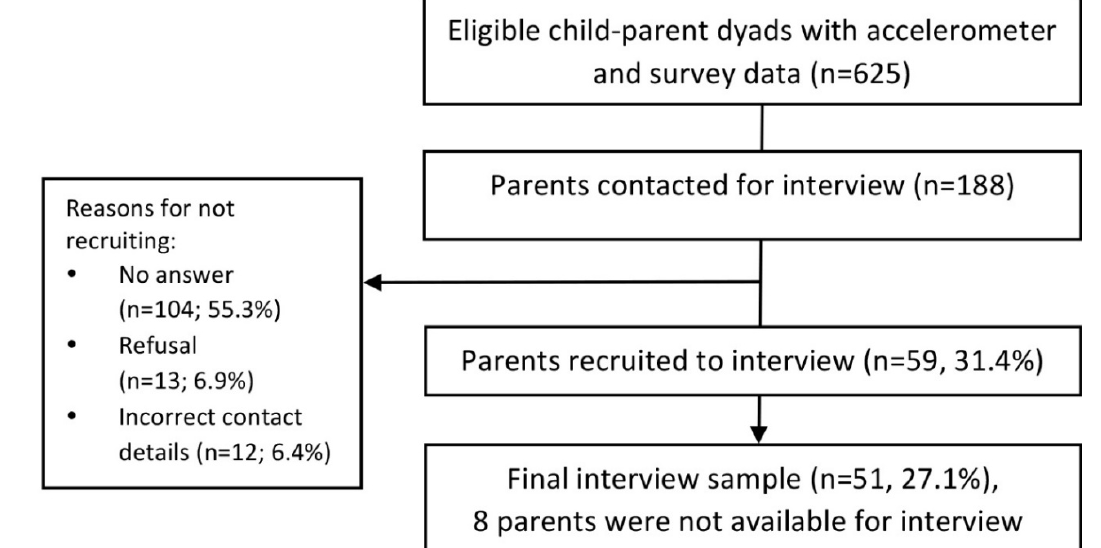
Figure 1. Study flow of participants.